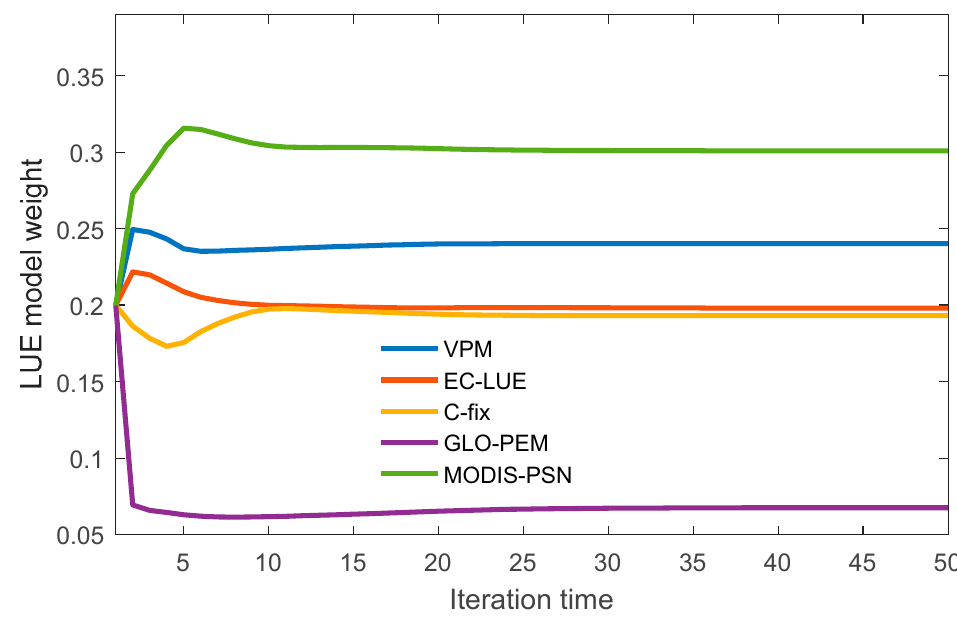
Figure 3. Residual plots of different models at the five sites (a: VPM; b: EC-LUE; c: C-fix; d: MODIS-PSN; e: GLO-PEM; f: BMA). The dashed line is the 1*SD and 2*SD (SD = 25 gC/m 2 /8 day for the GPP measurement at Arou site).